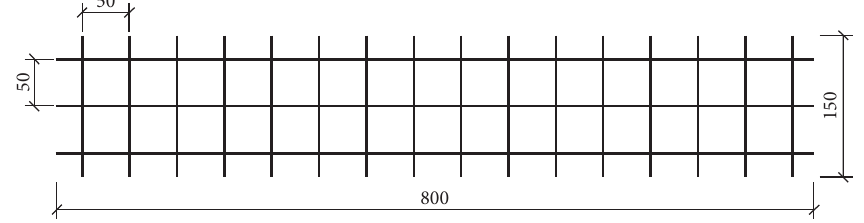
Figure 2: BFRP grid (unit: mm).